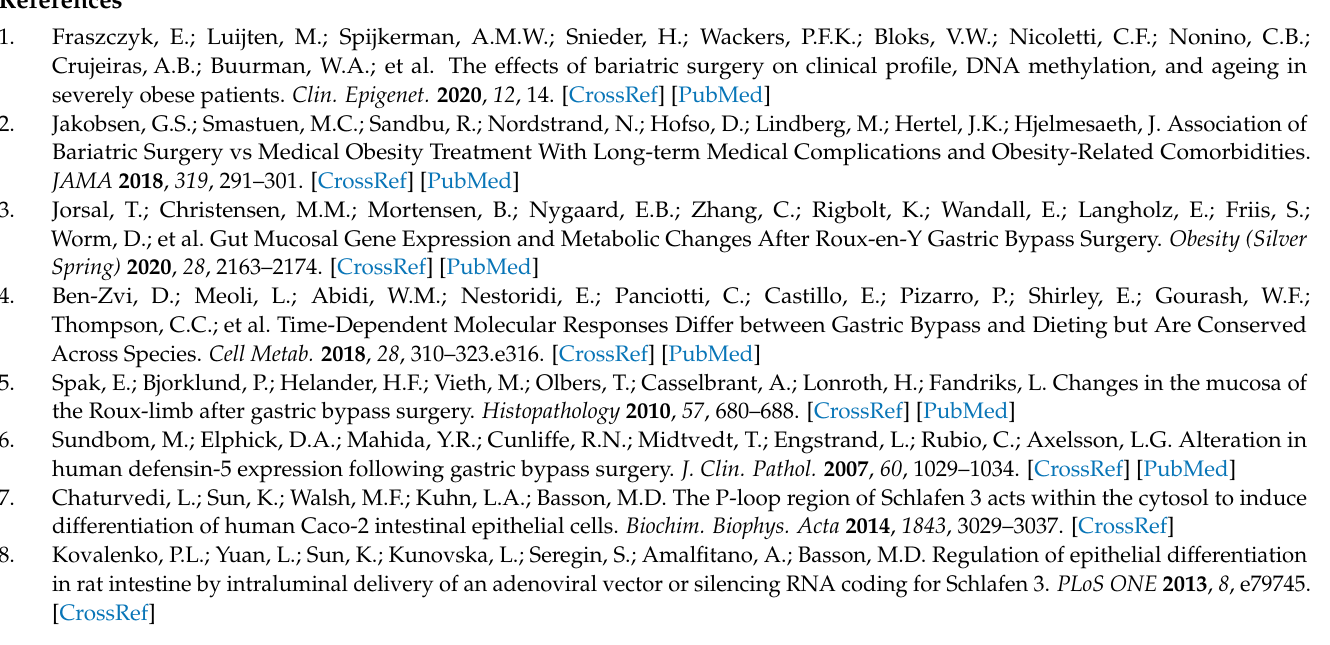
Table S4: Genes that highly correlated with respect to changes in percentages of BMI when measured pre- and post- the RYGB condition. Table S5: 19 genes that changed their expression significantly from Table S4 with respect to the change in